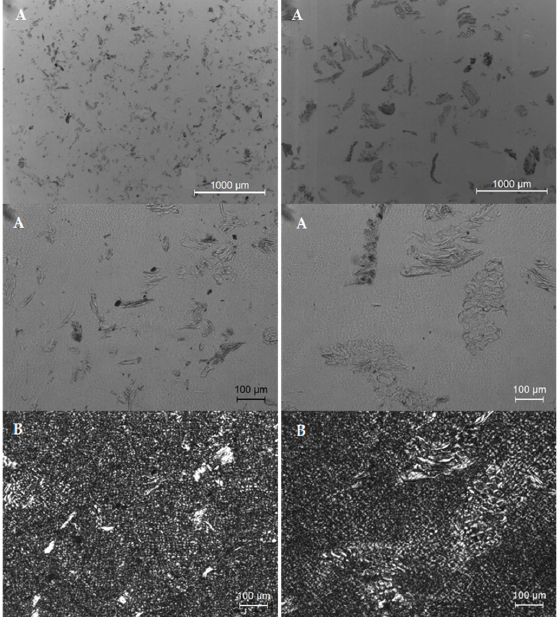
Figure 8. Optical microscopy images of MDPE/10 wt % wood with granulometries of <150 µm (images on the left ) and 300–500 µm (images on the right ), obtained by ( A ) bright field microscopy and ( B ) polarized light microscopy.